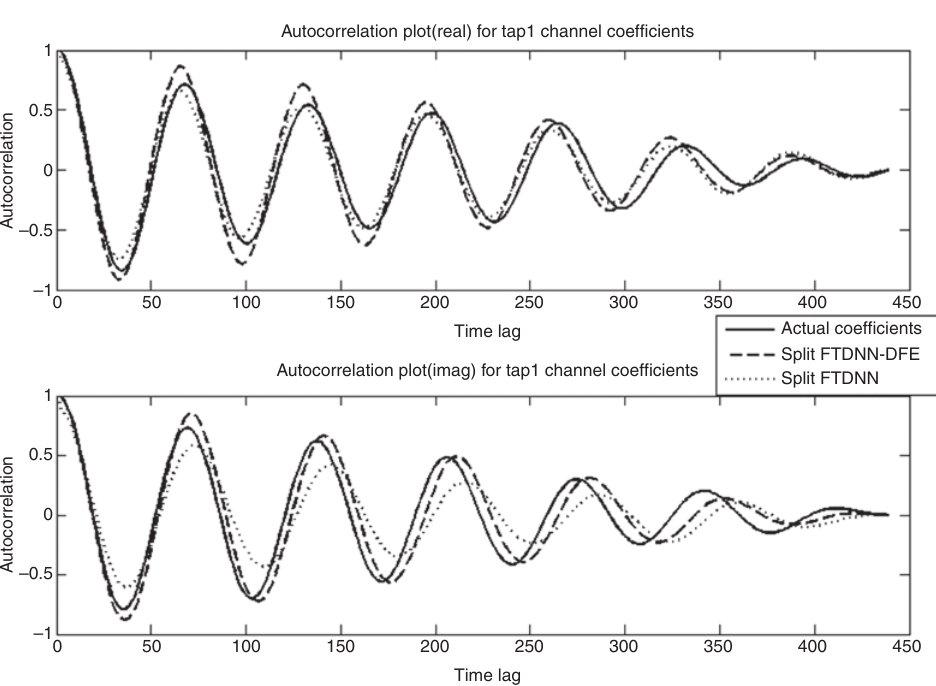
Figure 17: Autocorrelation Plot for Case 4.